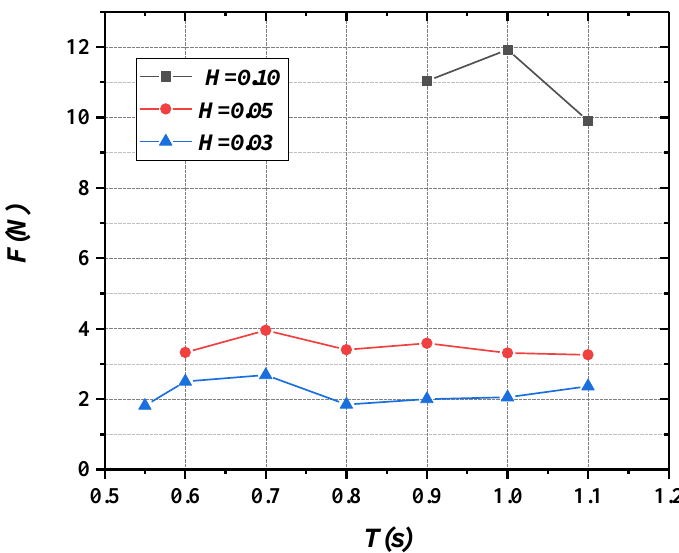
Figure 30. Variations of 1# mooring force.